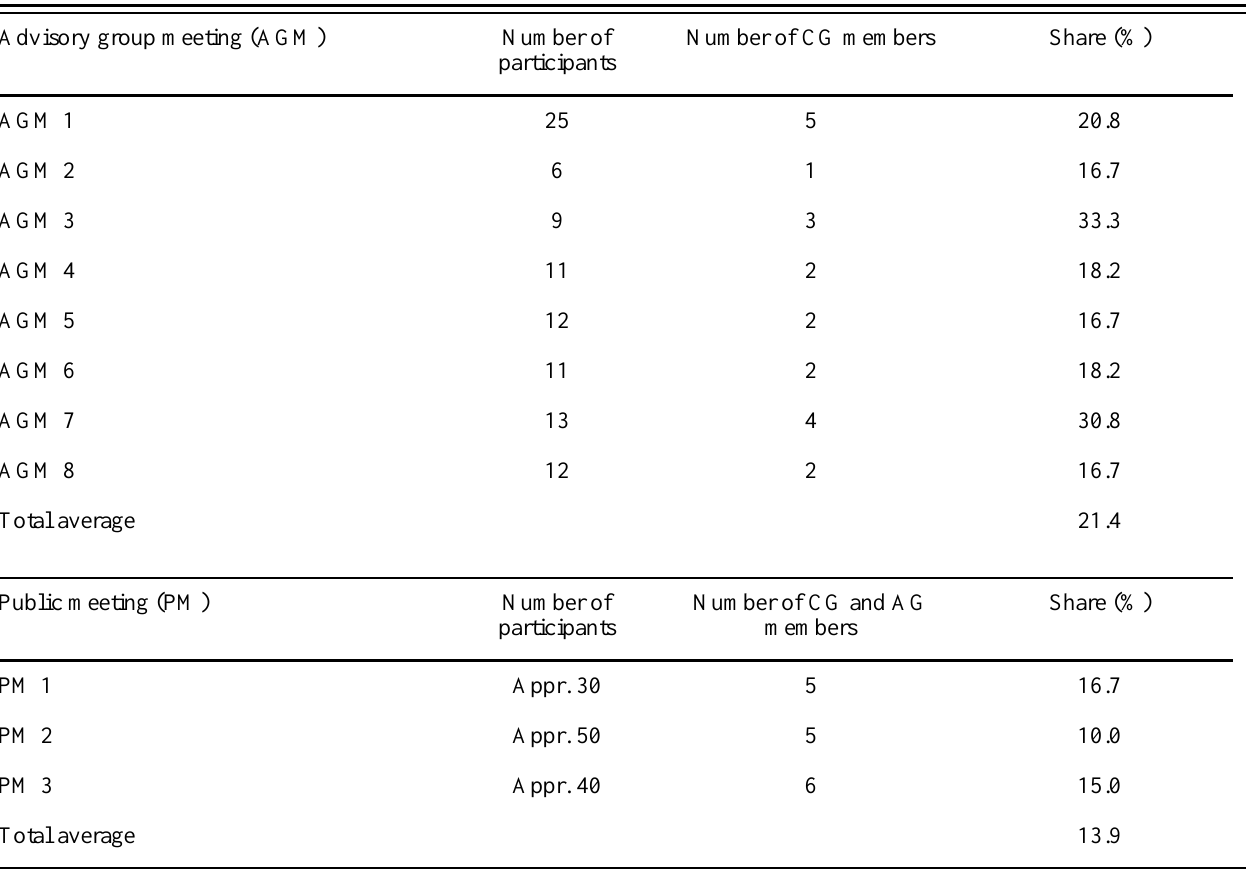
Table 5. Details on central group members participating in peripheral